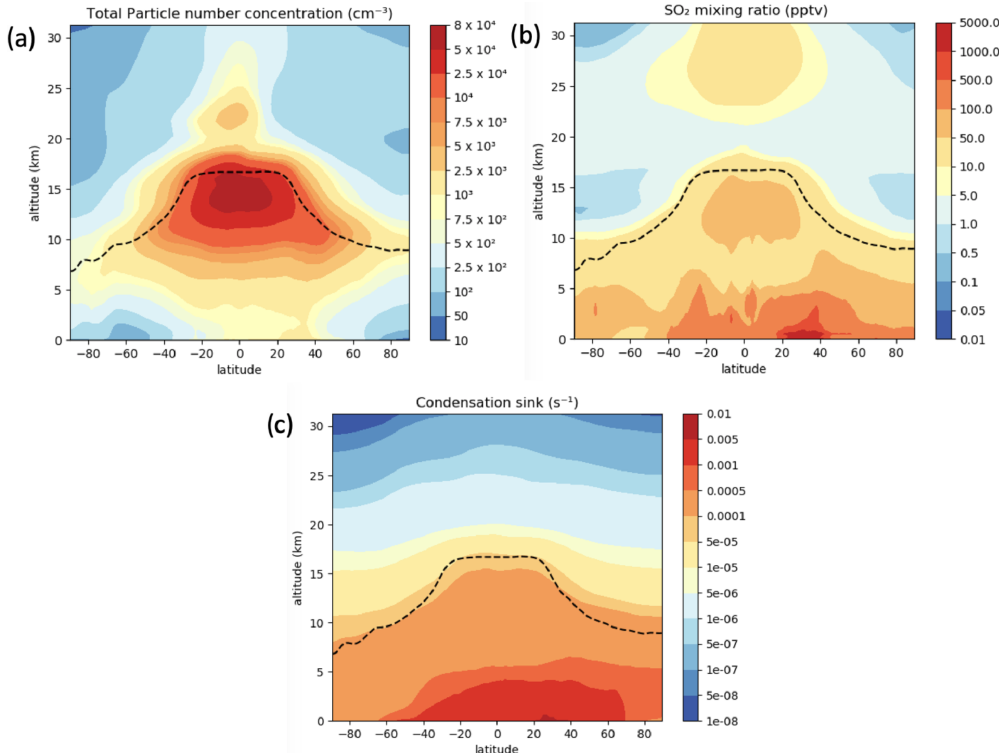
Figure 2. Global longitudinal mean vertical profile of the simulated (a) total particle number concentration ( N Total ), (b) SO 2 mixing ratio and (c) condensation sink from the default version of our model. In this figure, we show altitudes up to 30km, and our model top is 85km, but our analysis focuses on the troposphere. The black dashed line represents the tropopause